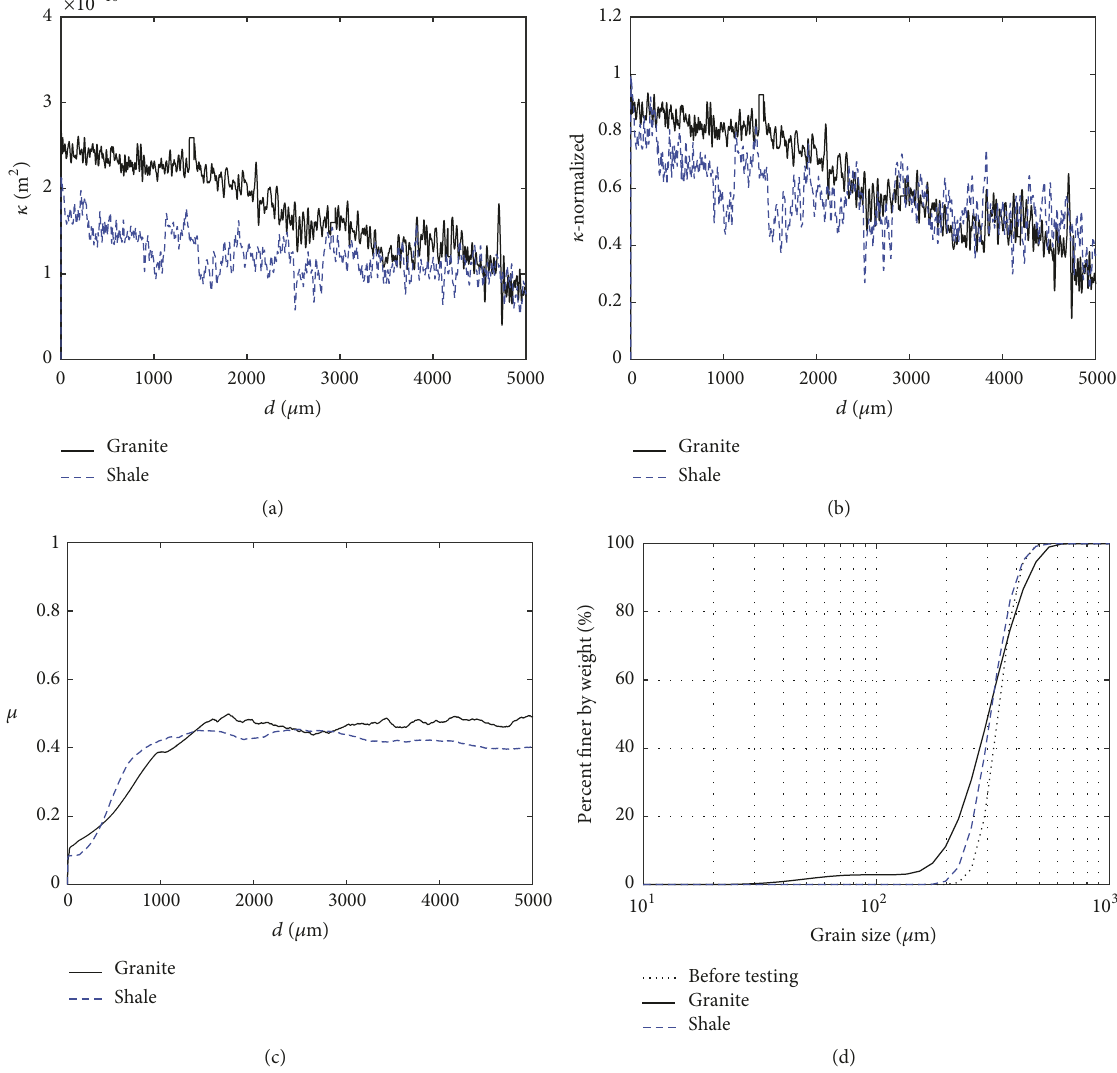
Figure 12: Evolution of (a) permeability, (b) normalized permeability (with respect to the initial permeability value), and (c) friction for the propped fracture during shearing for two different sandwiching fracture rock types: shale and granite with displacement; (d) particle size distributions (PSD) of proppants both before and after the experiments. The confining stress is 3MPa and the proppant size is 40/80 mesh for both